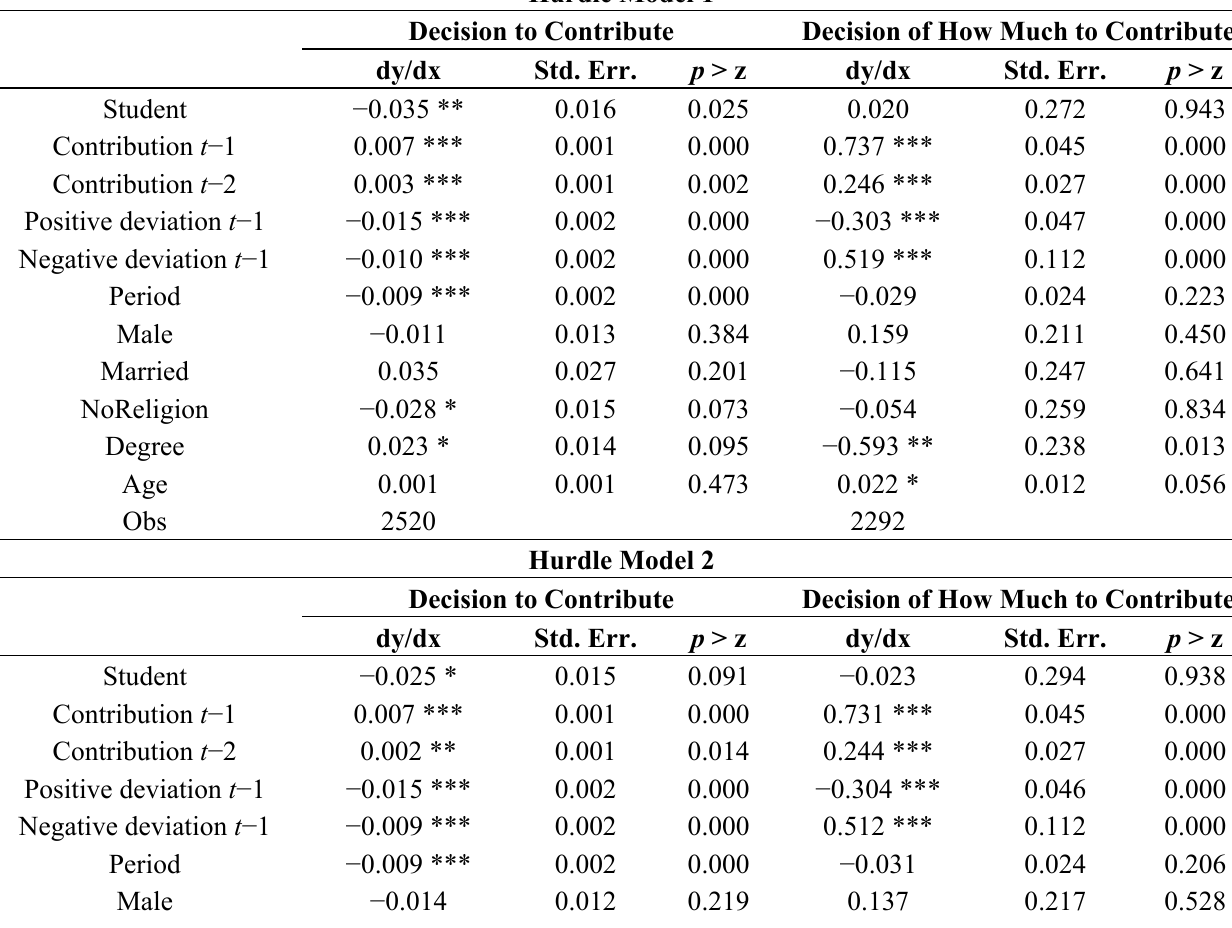
Table A14. Poisson-logit maximum-likelihood hurdle model.